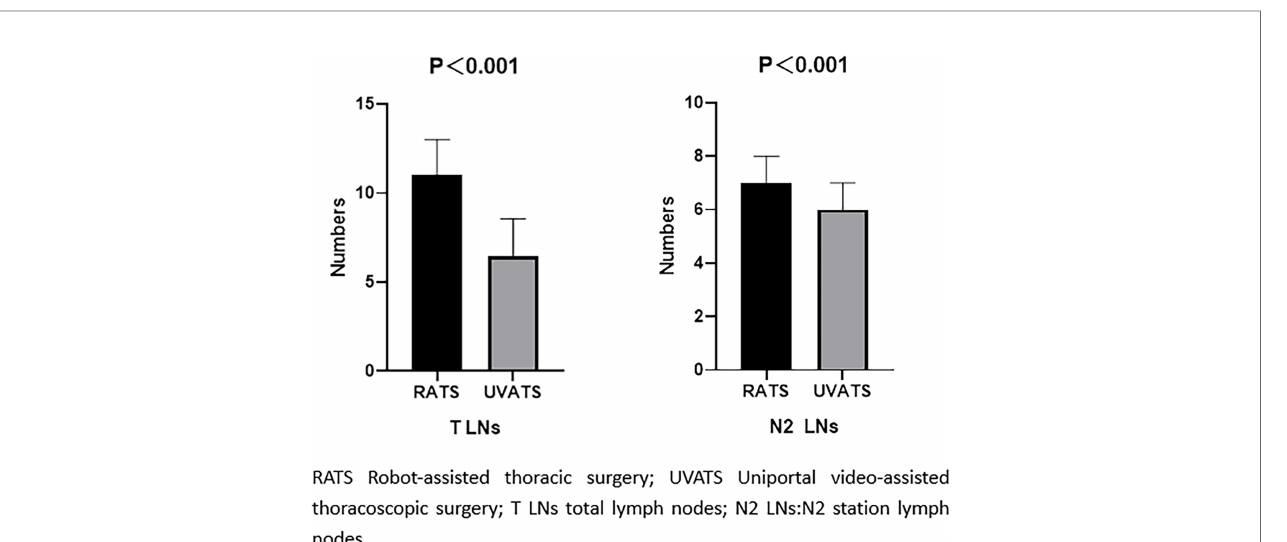
FIGURE 2 | Comparison of the number of lymph node dissection in matched cohort. The model was adjusted for age, sex, smoking, lobe, operation method,